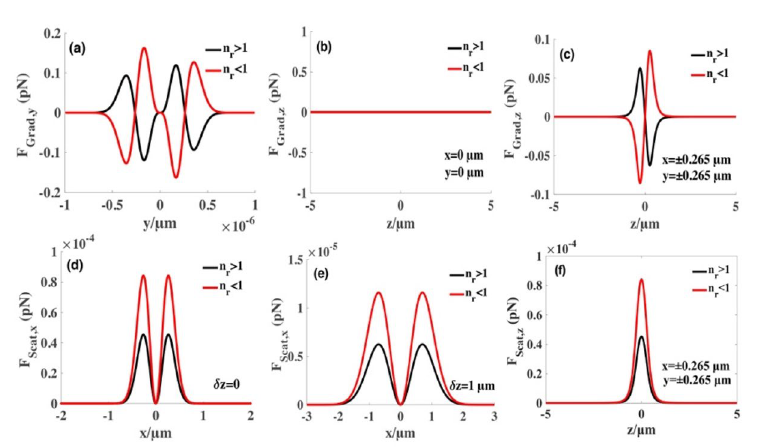
Figure 4. Radiation forces produced by focused SMGBs on high-index ( n p = 1.592 ) and low-index ( n p = 1) particles. ( a ) Transverse gradient force at the focus plane along the y direction. ( b ) Longitudinal gradient force exerted on Rayleigh dielectric spheres at x = 0 µm, y = 0 µ m . ( c ) Longitudinal gradient force exerted on Rayleigh dielectric spheres at x = ± 0.265 µ m, y = ± 0.265 µ m . ( d , e ) The transverse scattering force produced by SMGBs at different planes. ( f ) Longitudinal gradient force exerted on Rayleigh dielectric spheres at x = ± 0.265 µ m, y = ± 0.265 µ m . We select a sphere with a radius a = 20nm and n r = n p / n m to represent the relative refractive index. n m = 1.332 is the refractive index of the surrounding field, and the high and low refractive indices are the homogeneous Rayleigh nanospheres. Other parameters are (cid:31) = 1.064 µ m , w 0 = 5mm , f = 5 mm , P = 4 w , and the sine-modulation coefficient g = 1